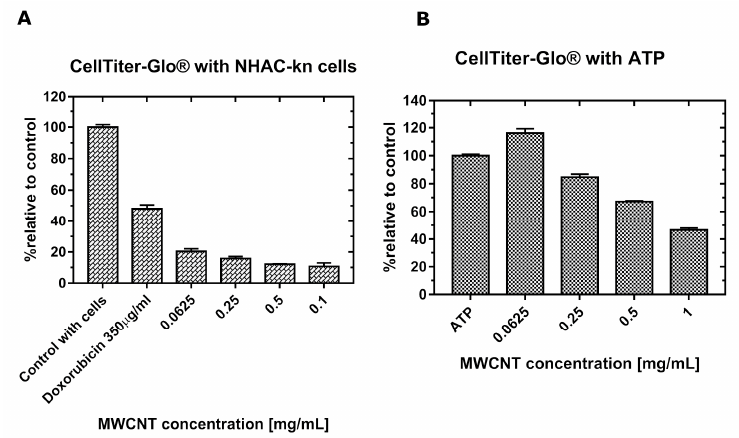
Figure 4. The plots represent relative cytotoxicity of MWCNT-Ox on NHAC-kn cells after 48 h ( A ) and signal of luminescence measured with the same concentrations of ATP and various concentrations of MWCNTs ( B ). Interference with the luminescent signal is visible. Doxorubicin as a positive control caused the death of over 50% of the cells.